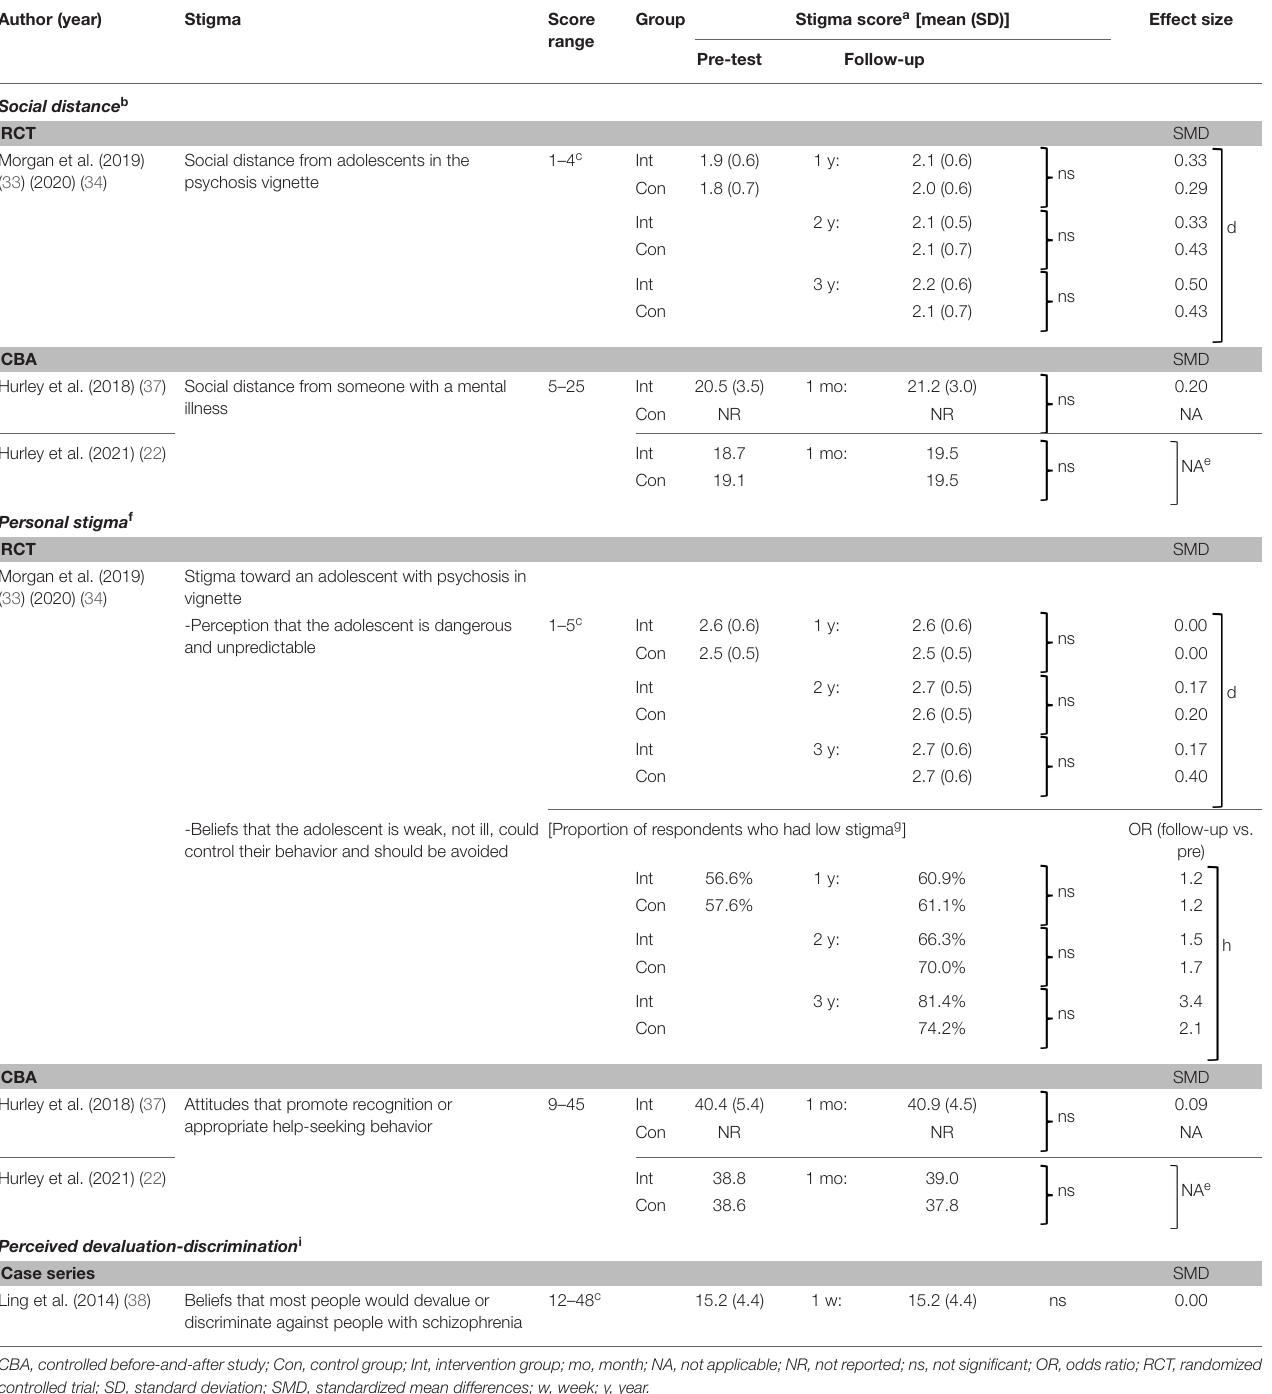
TABLE 5 | Effects on stigma toward people with mental health problems. Author